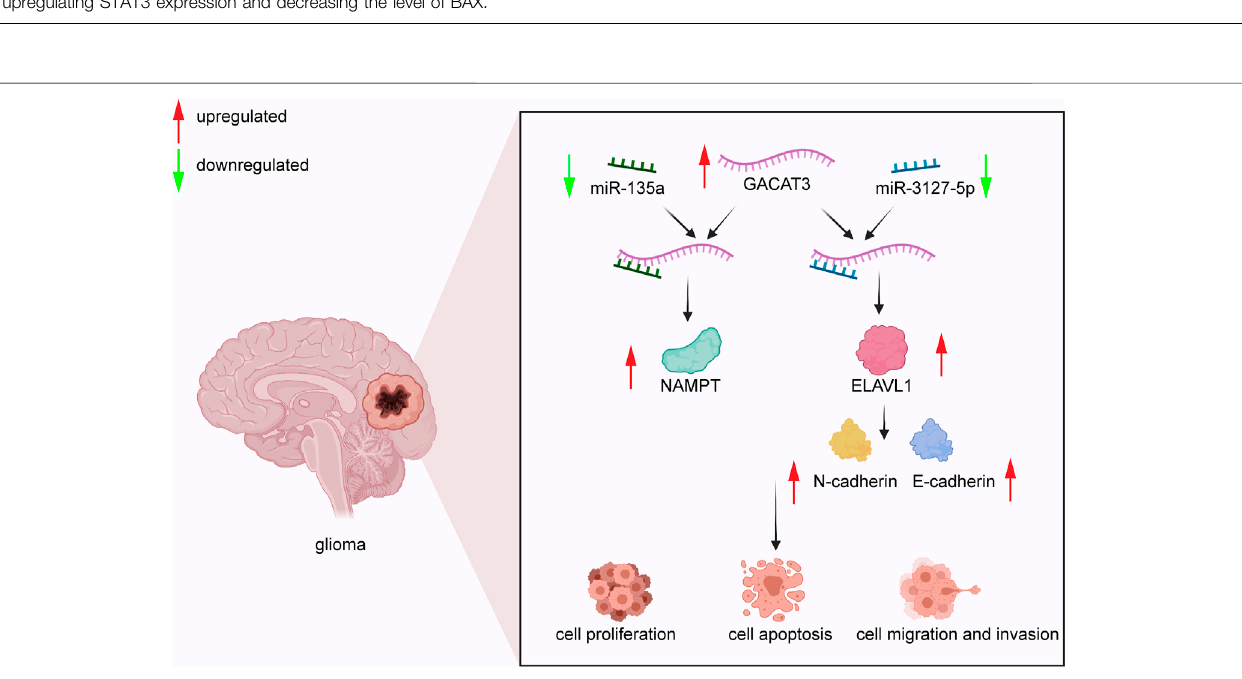
FIGURE 2 | GACAT3 in glioma. GACAT3 elevates the level of NAMPT by interacting with miR-135a to mediate glioma cell proliferation. Additionally, GACAT3 inhibits cell apoptosis by binding miR-3127-5p and consequently elevating ELAVL1 levels. Elevated ELAVL1 levels also enhance EMT by altering the balance of N-cadherin and E-cadherin. As a result, the GACAT3 /miR-3127-5p/ELAVL1 pathway promotes cell migration and invasion.